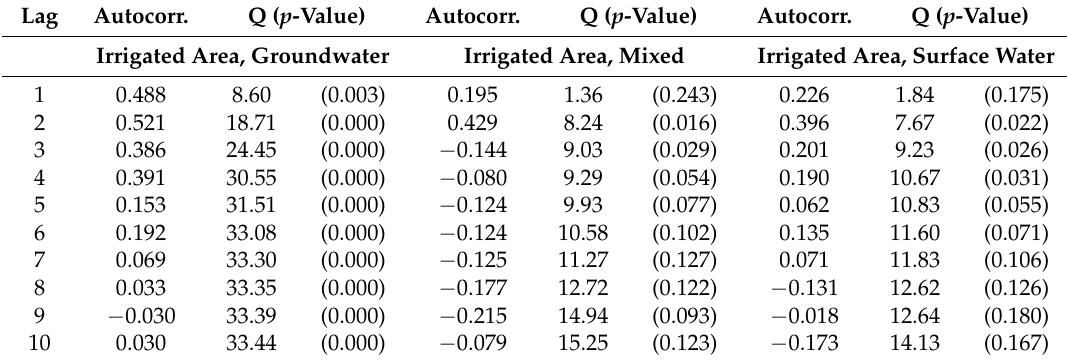
Table A2. Autocorrelation and Q-statistics, time series in Figure 5.